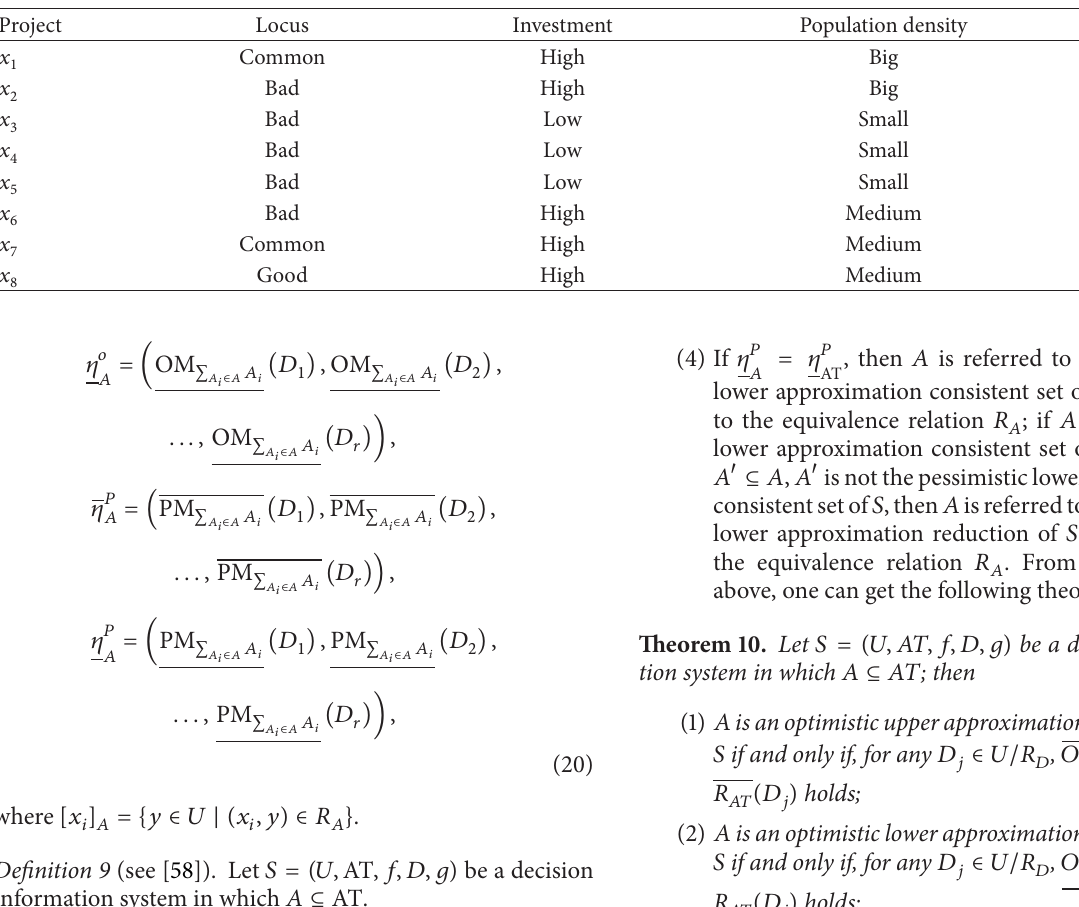
Table 1: A target information system about emporium investment